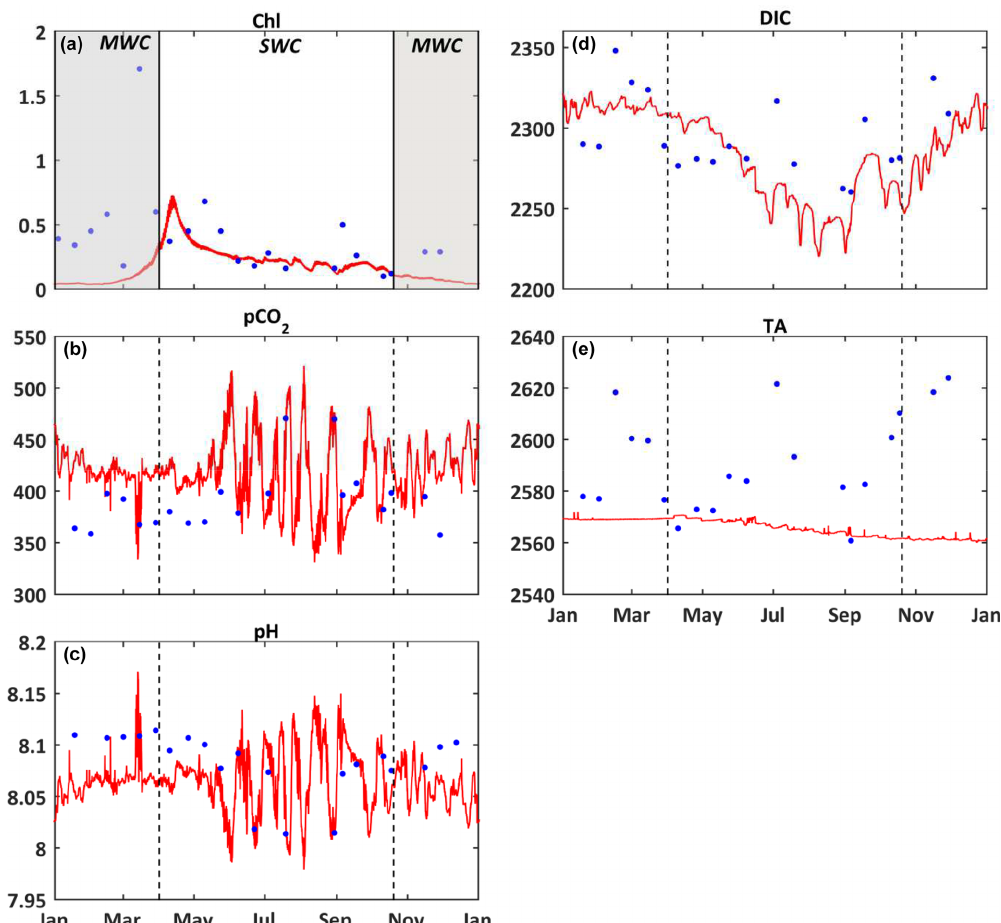
Figure 3. Comparison of model results (red) and in situ data (blue) at the surface of the SOLEMIO station. (a) Chlorophyll a concentrations (mgm − 3 ), (b) p CO 2 (µatm), (c) pH, (d) DIC (µmolkg − 1 ), (e) TA (µmolkg − 1 ). The value of each state variable represents the mean around ± 5d of the seawater sampling date. The shaded area and dotted black line delimit the SWC and MWC periods. Table 2. Statistical evaluation of observations vs. model for 2017: observed and simulated minimum and maximum values. WSS = Willmott skill score; N = number of measurements. Units of bias are those of modeled variables: chlorophyll a (Chl a , mgm − 3 ), seawater